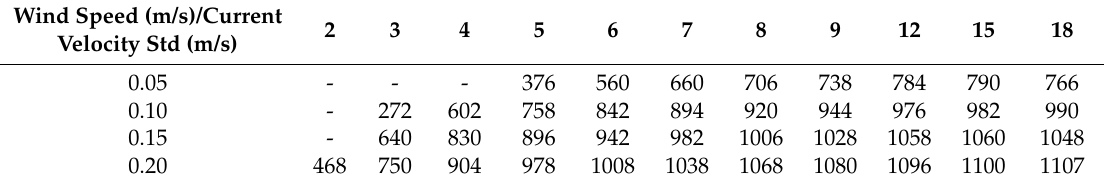
Table 12. Current field effective swaths of different current velocity Stds in different wind speeds. Wind Speed (m/s)/Current